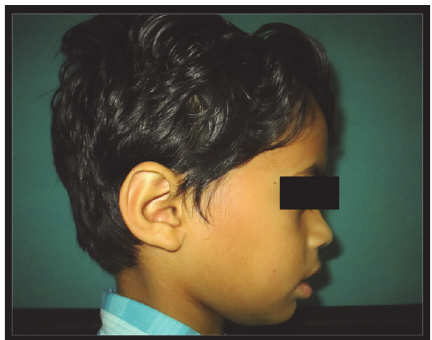
Figure 1: Presence of cup-shaped ear and prominent parietal aspect of head.